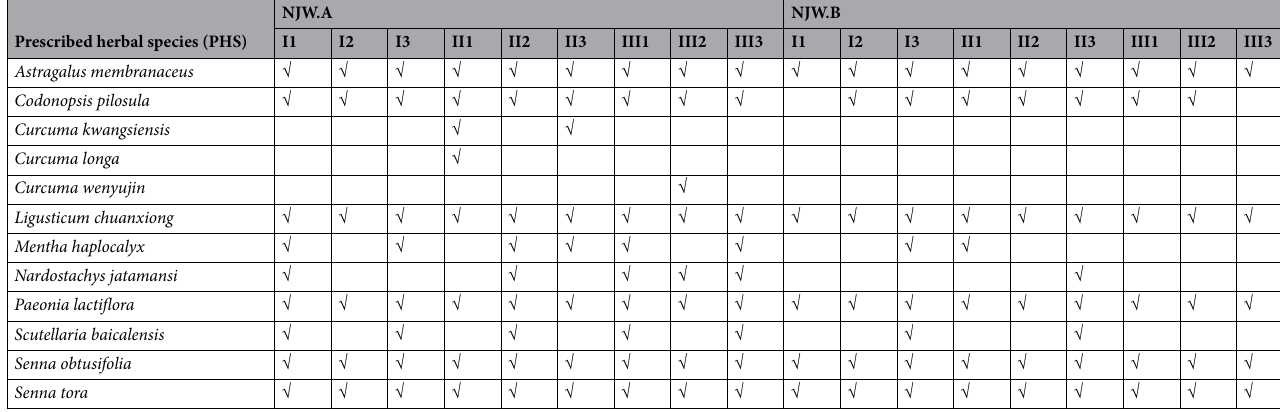
Table 3. Prescribed herbal species for NJW preparation and their presence in each sample by the multi- barcode sequencing approach based on ITS2 biomarker. Note that “NJW.A” and “NJW.B” means the “Niuhuang Jiangya Wan” bought from manufacturer A and B, respectively. “I1” represents the sample as one of three biological replicates of the first batch sample, and the “√” means that the prescribed herbal species is detected in this